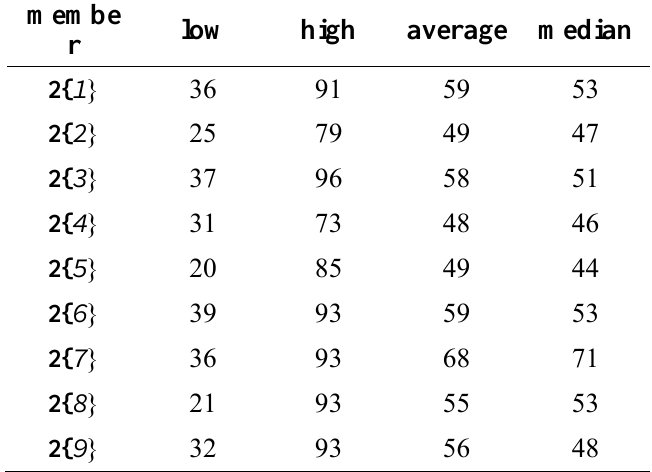
Table 5. Yields of purified library members based on amino acid